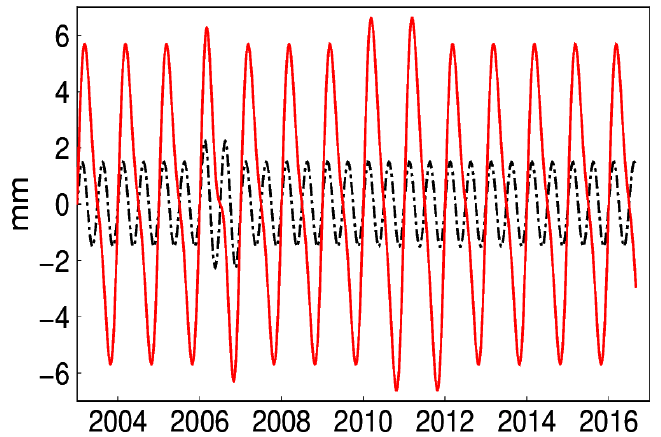
Figure 16. Time-varying semi-annual signal and synthetic signal.